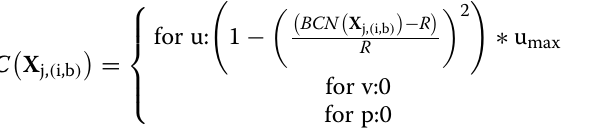
Table 1 Network and hyper parameter settings used in the experiments SEN PINN BCN Network parameter Layers 4 1d Convolutions (feature size: × 128, 128, 256, 512) FCN (3 hidden layer with 256 neu‑ rons, n k 60); β = 0.001 = Training parameter Batch size 50 10 10 Optimizer Adam [16] Betas Learning